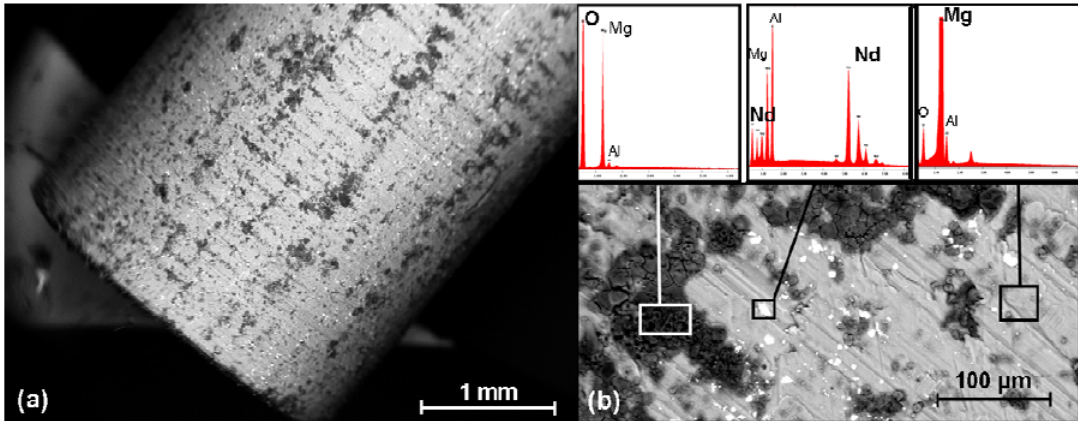
Figure 6. SEM images prior to implantation: ( a ) Overview of the pin’s surface prior to the test; ( b ) EDX analysis of the pin’s surface: preferentially detected Mg, Al, Nd and O. Each of the boxes mark the regions selected for the EDX